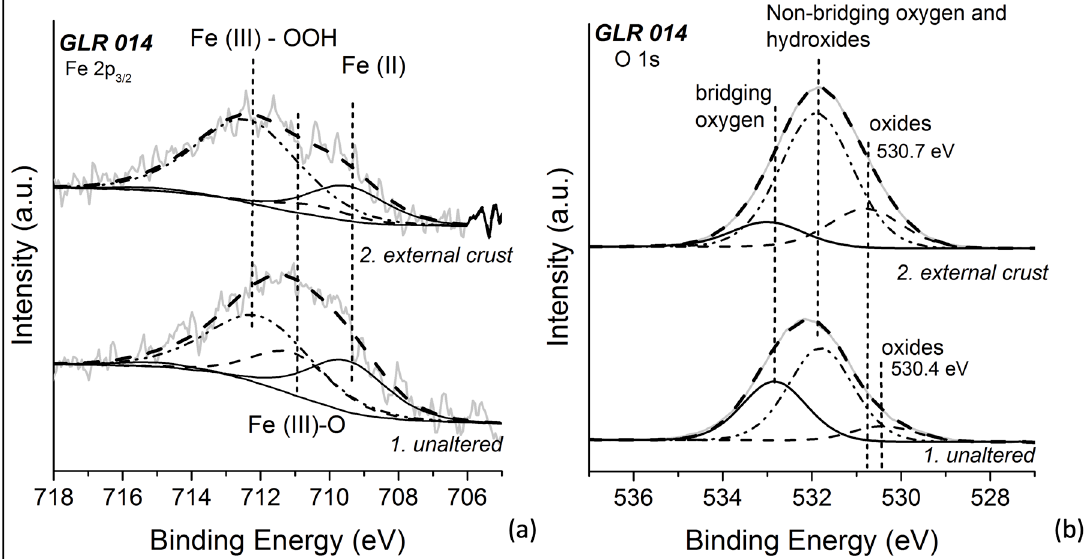
Figure 10. Fe 2p 3/2 peaks recorded points 1 and 2 of sample GLR 014 ( a and b respectively) as well as the O 1s peaks recorded in of sample GLR 014 ( a and b respectively).